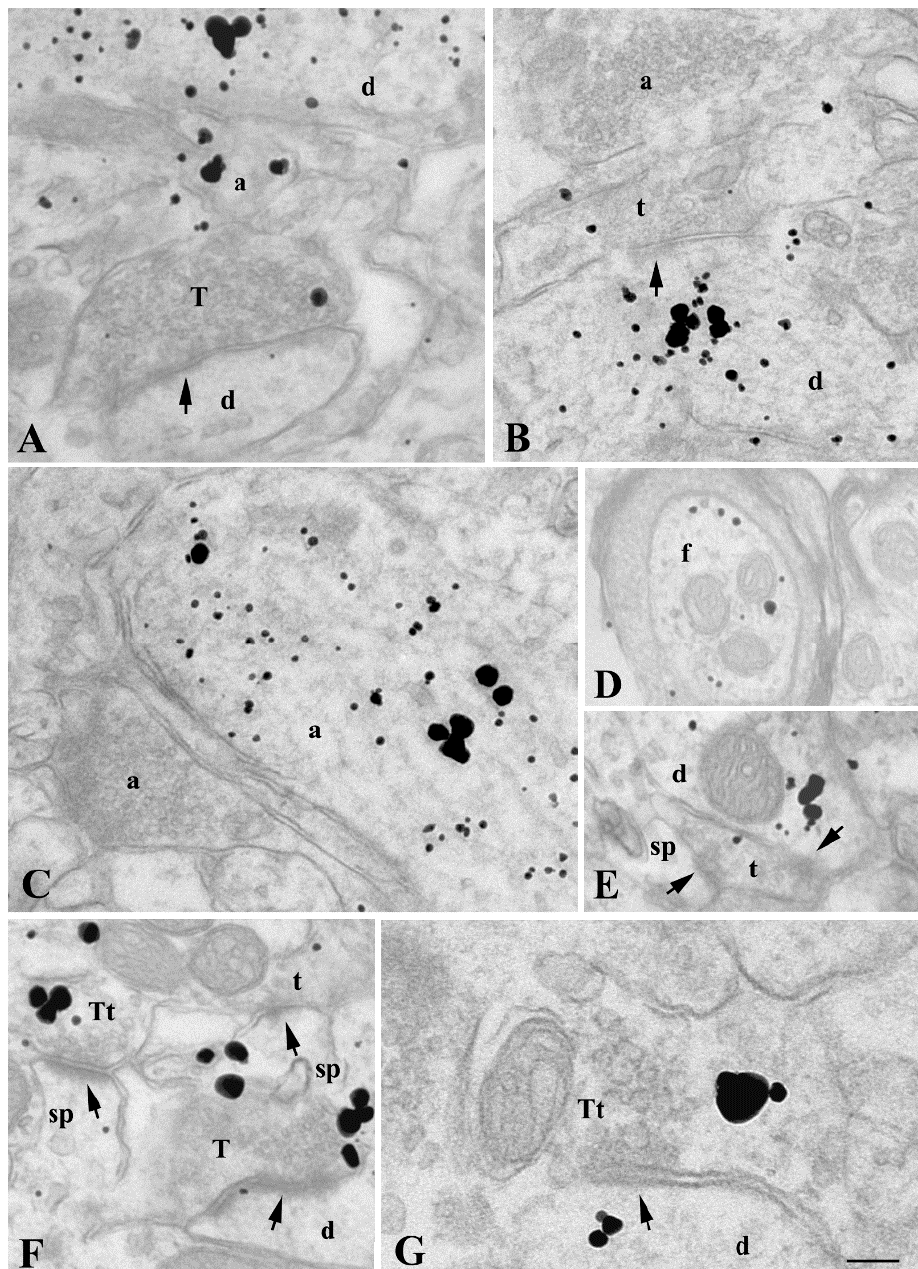
Figure 7. Immunoelectron microscopical localization of α-synuclein and α-tubulin in murine corpus striatum . Representative electron micrographs of α -synuclein (large silver-intensified gold particles) and α -tubulin (small silver-intensified gold particles) pre-embedding immunogold colocalization performed in C57BL/6J mice ( n = 3). The colocalization appeared mainly in proximal dendrites (d), as shown in ( A , B , E ), as well as in some, but not all, small and large vesicle-containing axonal (a) profiles ( A , C ). Some poorly myelinated fibers (f in ( D )) and small axonal terminals forming synaptic contacts (arrows) with proximal dendrites (d) and dendritic spines (sp) displayed single α-tubulin immunolabelling (t in ( B , E , F )), whereas single α -synuclein immunolabelled synaptic boutons (T) contacting (arrows) distal dendrites (d) were shown in ( A , F ). Finally, double α -synuclein and α-tubulin immunogold staining was displayed by some small synaptic terminals (Tt) forming either asymmetric postsynaptic specializations (arrows in ( F )) on dendritic spines (sp) or symmetric synapses (arrow in ( G )) with α -tubulin-positive dendrites (d in ( G )). Scale bar: 200 nm ( A – F ), 100 nm ( G ).